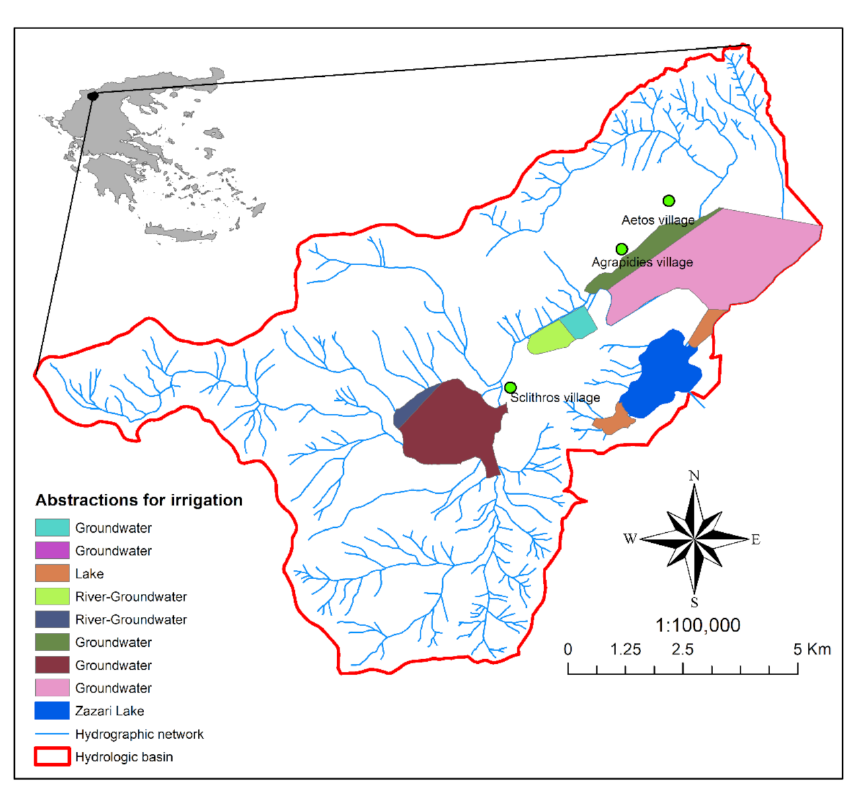
Figure 3. Spatial extent of irrigation command areas and their water source in the hydrological model of Lake Zazari basin.